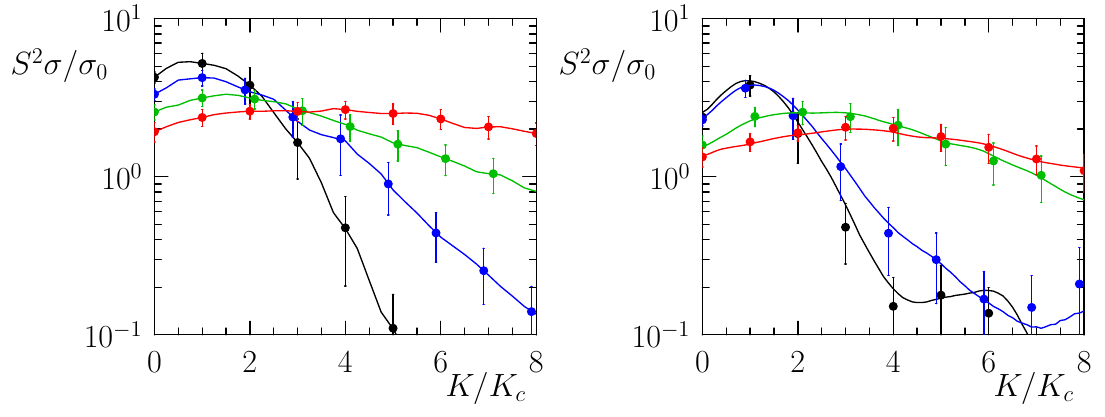
Figure A5. Dependence of the power factor P S = S 2 σ / σ 0 on system parameters. Left panel: ν = N / L = 34/21, T / K c = 0.25,1,2,4.25 (black, blue, green, red colors), K c = 0.019. Right panel: ν = N / L = 55/21, T / K c = 0.25,0.5,1.5,2.5 (black, blue, green, red colors), K c =